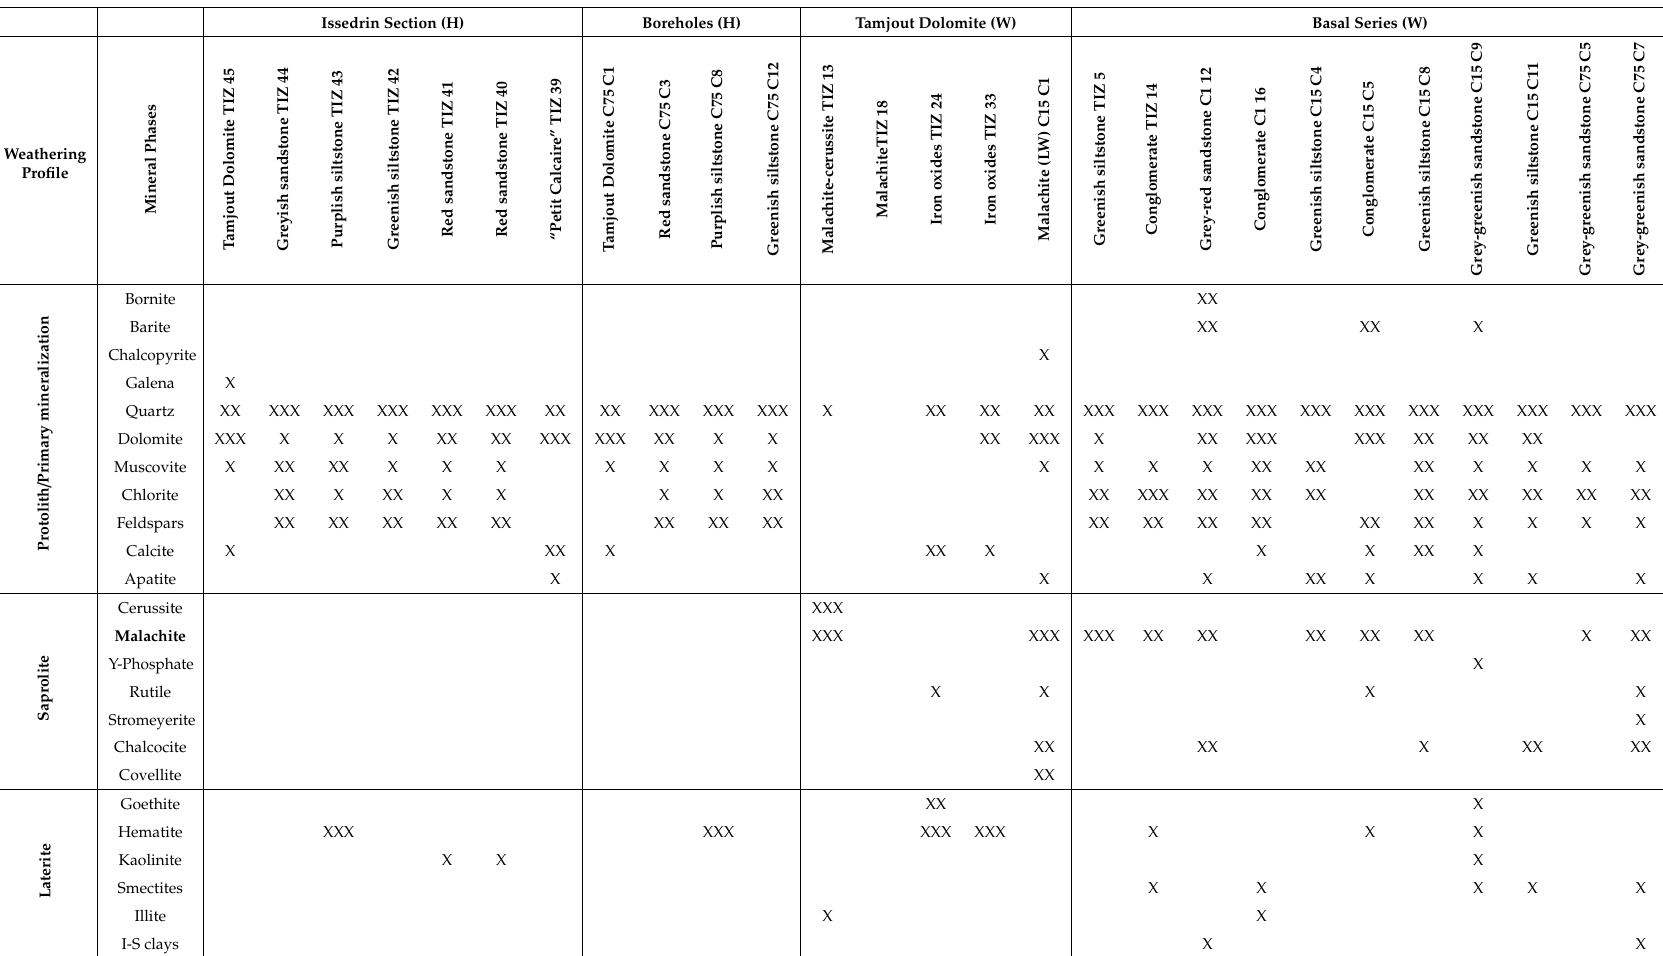
Table 2. Mineral phases observed in the di ff erent samples of the Tizert deposit (H—Host rocks; W—Weathered rocks; XXX—major; XX—frequent; X—minor). Issedrin Section (H) Boreholes (H) Tamjout Dolomite (W) Basal Series (W)